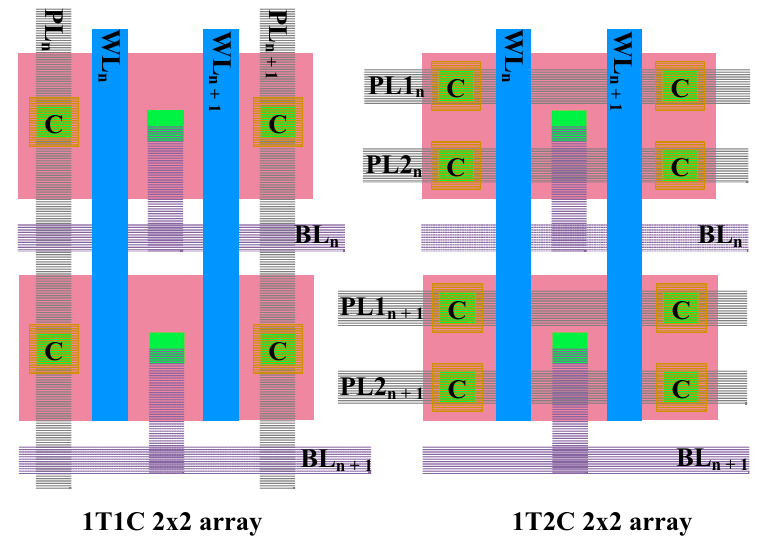
Figure 6. Layouts of the 1T1C and 1T2C FeCAP arrays.